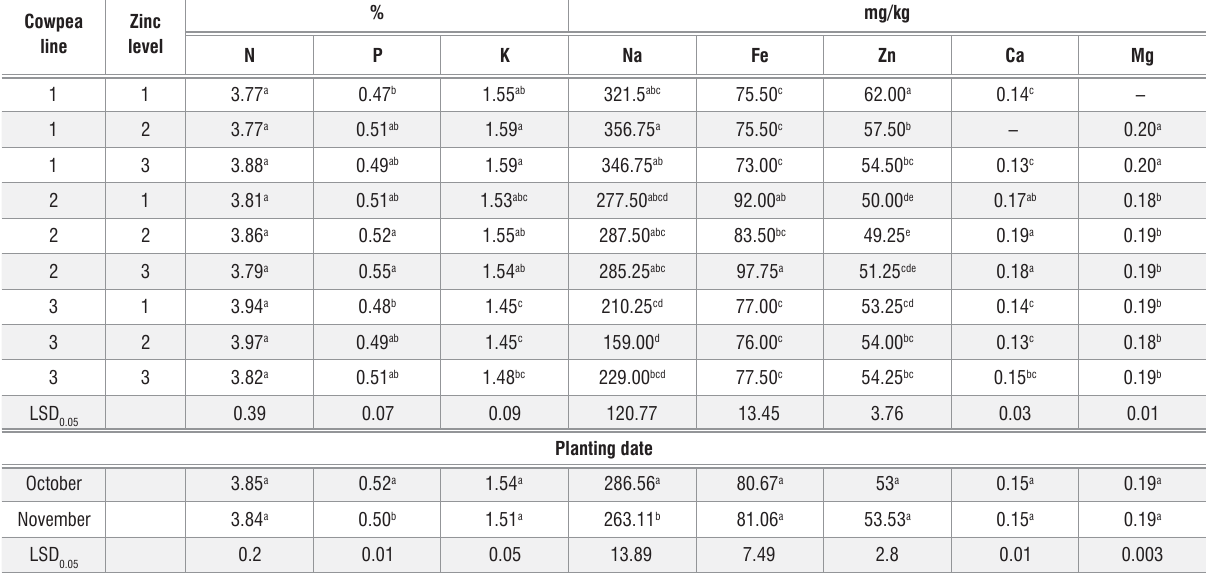
Cowpea seed mineral content after zinc application at Nietvoorbij Cowpea line